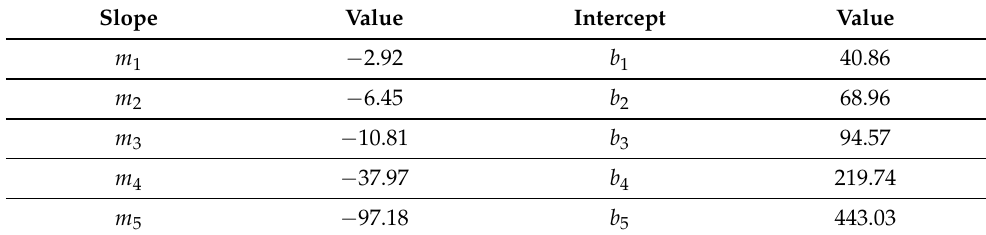
Table 2. Linear approximation of torque-speed